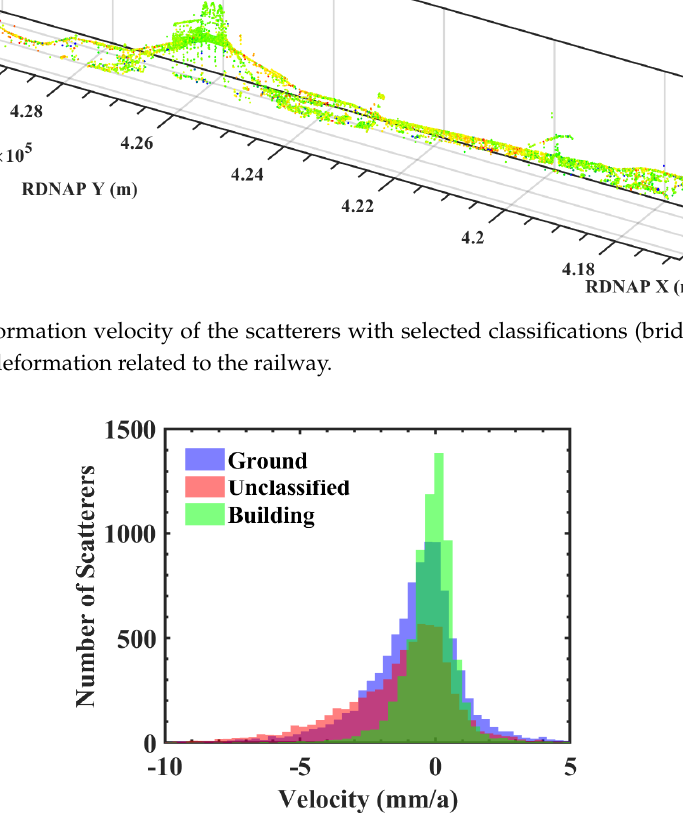
Figure 11. Histograms of the deformation velocity within different classes, showing a better interpretation of deformation signals with classified